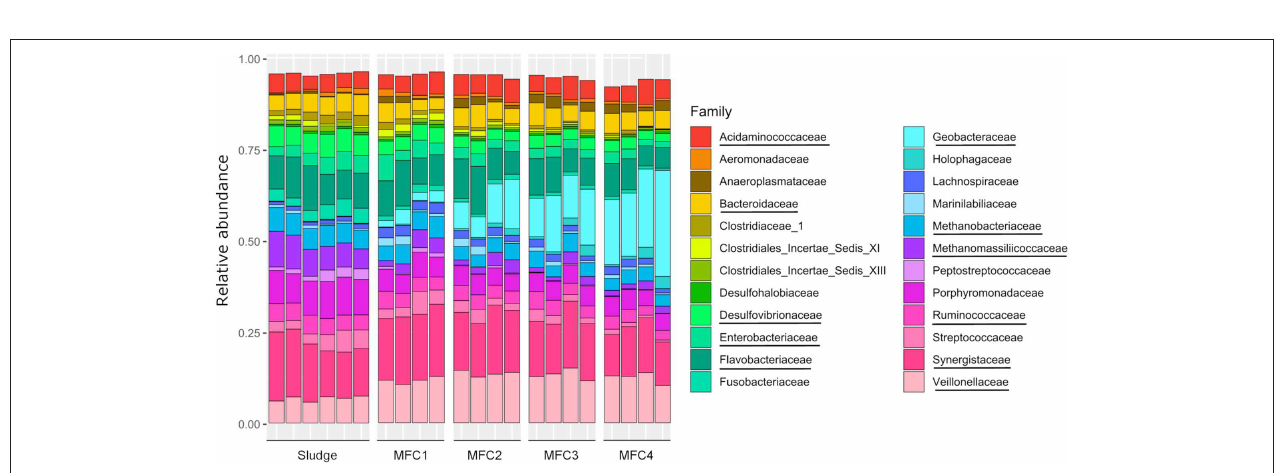
FIGURE 9 | NMDS plot of samples and taxa from bray-curtis dissimilarity matrix. The size of the ellipses for each genus is proportional to its relative abundance in all the samples. Genus with a short vector length or a low relative abundance were removed. Only the more significant environmental variables were kept (stress = 0.035).